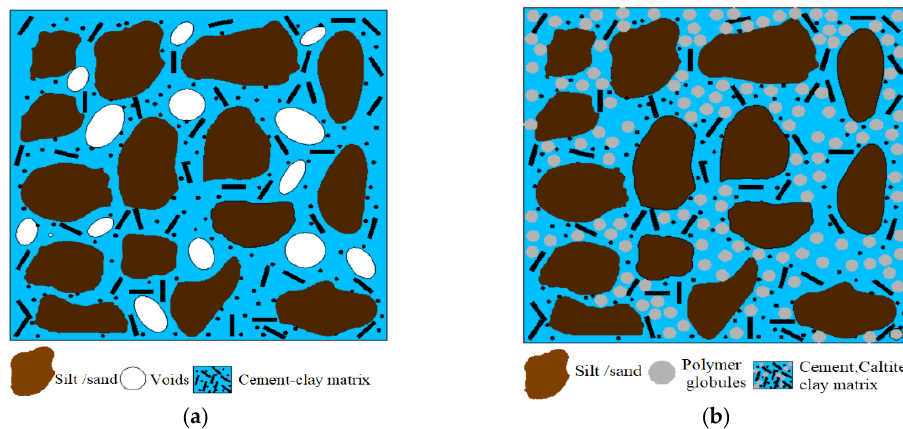
Figure 8. Schematic of the mechanism for strength components by ( a ) cement and ( b ) cement – caltite by polymer globules gathering in the cracks and void cement soil, reinforced by caltite.